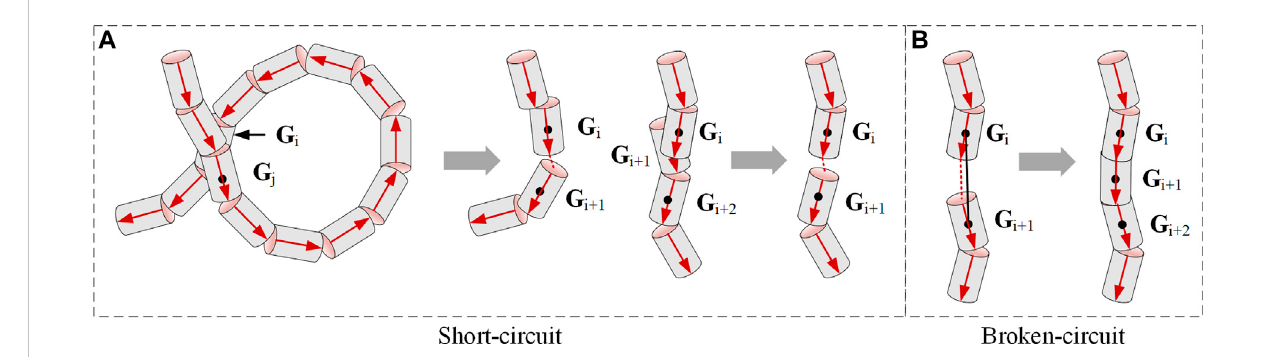
FIGURE 8 Two typical situations with (A) short-circuit and (B) broken-circuit.